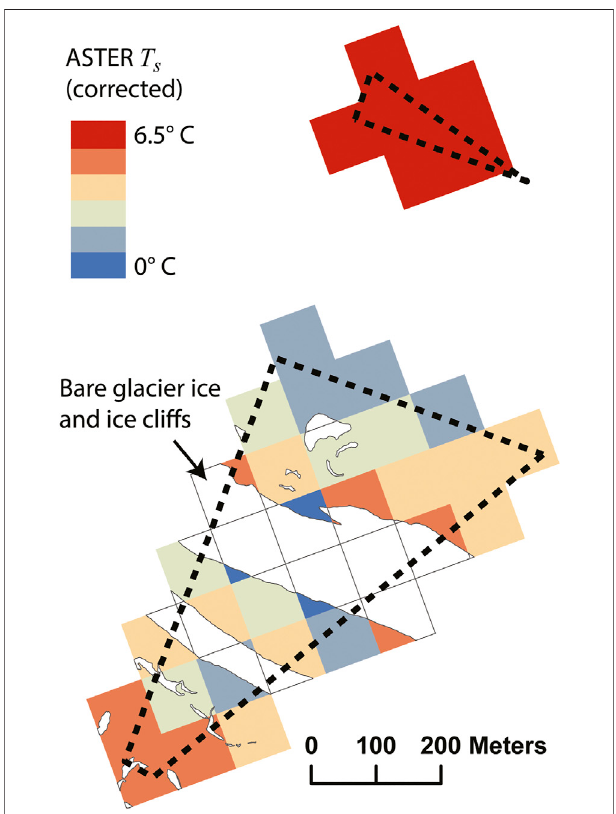
FIGURE 7 | Example of the linear spatial averaging ( Eq. 15 ) applied to ASTER surface temperature data. The sub-pixel area and thermal signal of locations known to be bare glacier ice, or ice cliff area, are removed. The dashed line outlines the study site ( Figure 1C ).